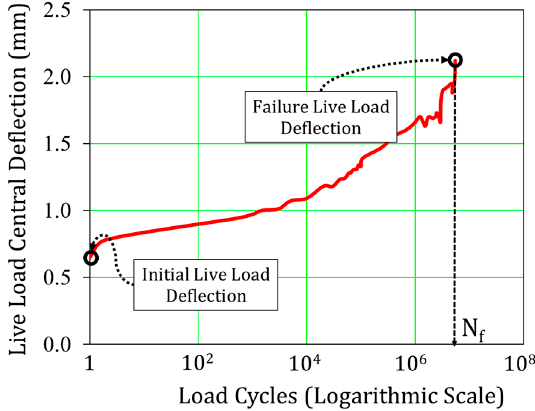
Figure 6. Experimentally obtained live load deflection with equivalent number of cycles.